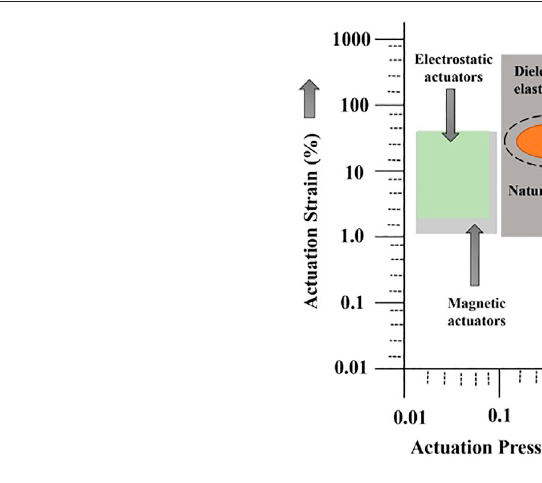
Frontiers in Materials |